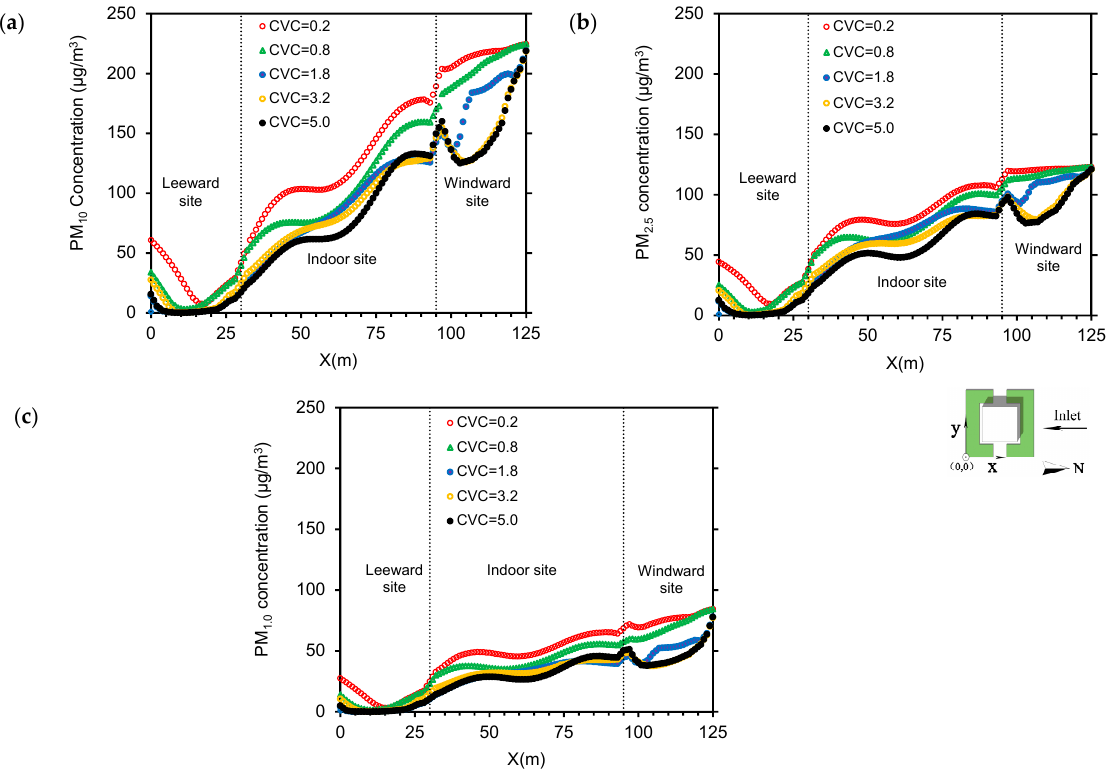
Figure 12. PM 10 ( a ), PM 2.5 ( b ) and PM 1.0 ( c ) along the horizontal plane at z = 1.5 m and y = 53 m (wall porosity = 3.5%).